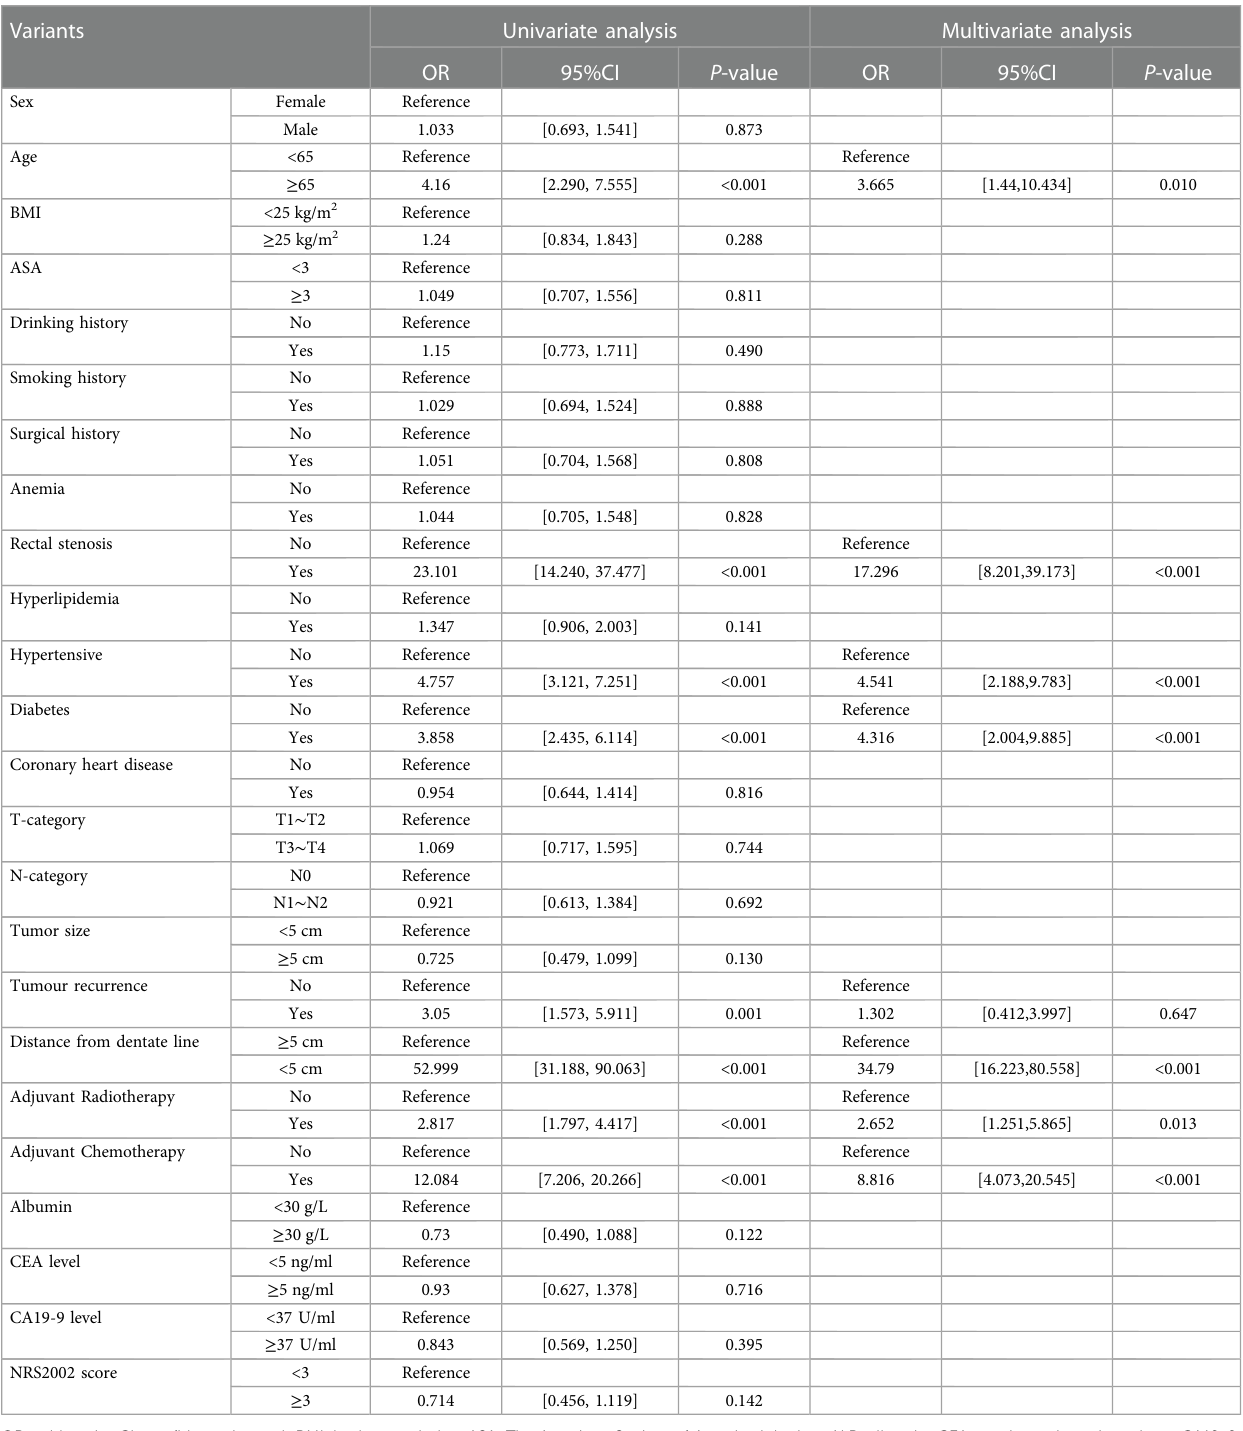
TABLE 1 Univariate and multivariate analysis of variables related to permanent